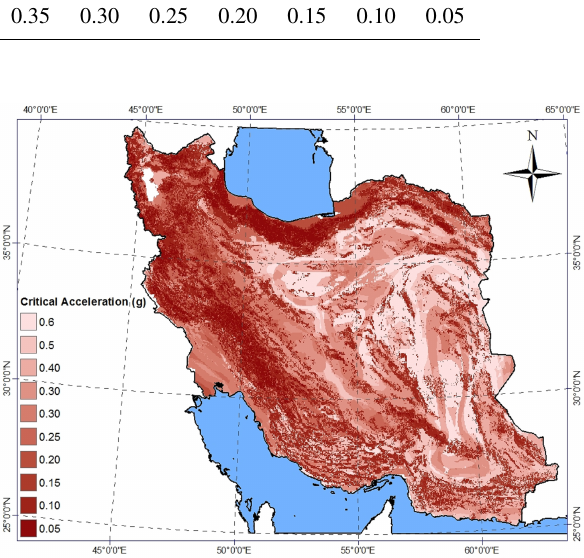
Figure 11. Liquefaction-induced displacement map of Iran.